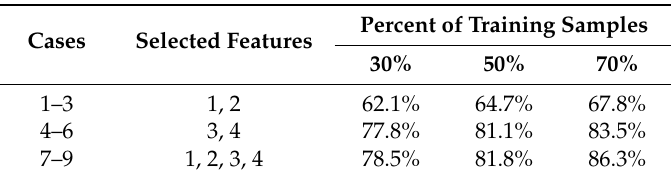
Table 7. Averaged rates of identification accuracy.